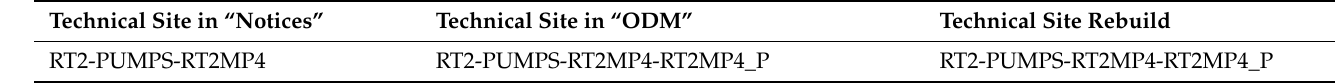
Table 3. Example of reconstruction of the technical site using the third